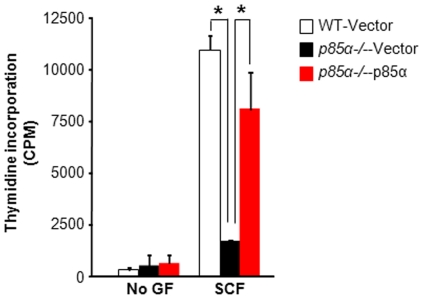
Reconstitution of p85α in to p85α−/− MCps completely corrects defective SCF-mediated growth.WT and p85α−/− MCps transduced with vector or p85α were sorted to homogeneity based on EGFP expression and cultured in the presence of IL-3 (10 ng/mL). Cells were starved for 6 hours in serum- and cytokine-free media and cultured in the presence or absence of SCF (50 ng/mL). After 48 hours, proliferation was evaluated by a [3H] thymidine incorporation assay. Bars represent the mean [3H] thymidine incorporation in BMMCs (CPM ± SD) from one representative experiment performed in quadruplicate. Similar results were observed in three independent experiments. *p<0.01, WT-vector vs. p85α-/–vector; *p<0.01, p85α-/–vector vs. p85α-/–p85α.